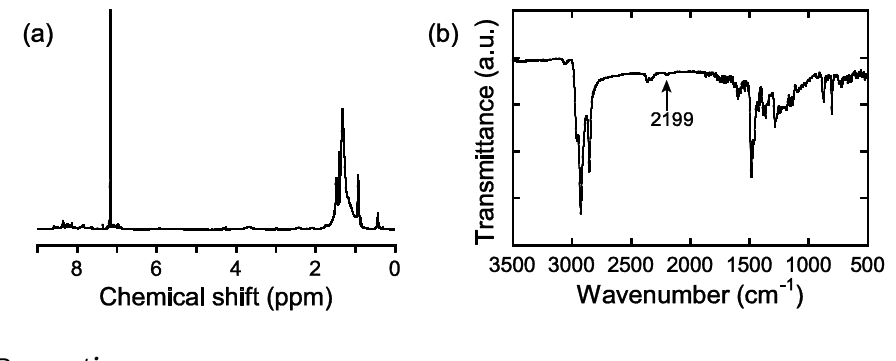
D and (b) IR spectrum of P4 (KBr). 6 6